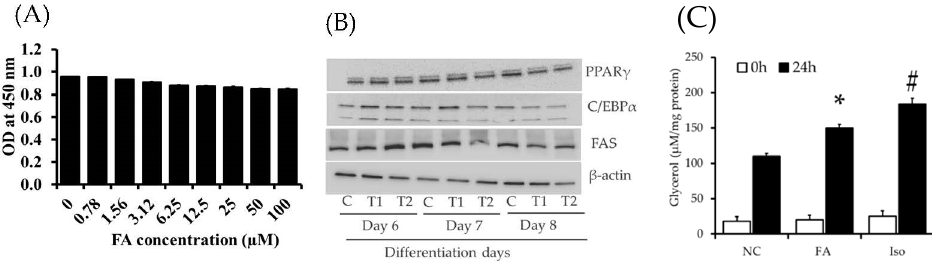
Figure 1. Impact of ferulic acid (FA) on cell viability, key adipocyte factors, and glycerol release. ( A ) Cells treated with different concentrations of FA and determined its toxic effect on 3T3-L1 pre-adipocytes using EZ-cytox kit; ( B ) changes in key differentiation protein markers and its downstream target in response to FA treatment at different days; ( C ) 3T3-L1 adipocytes were treated with FA and Isoproterenol (ISO) at 10 µ M, followed by the amount of glycerol content release into media from differentiated adipocytes for 0 and 24 h were quantified. C: control; T1: 5 µ M; T1: 10 µ M; Data are represented as the mean ± standard error of the mean three replicates. * p < 0.05 control vs. FA treatment; # p < 0.05; ISO vs. control and FA treatment.